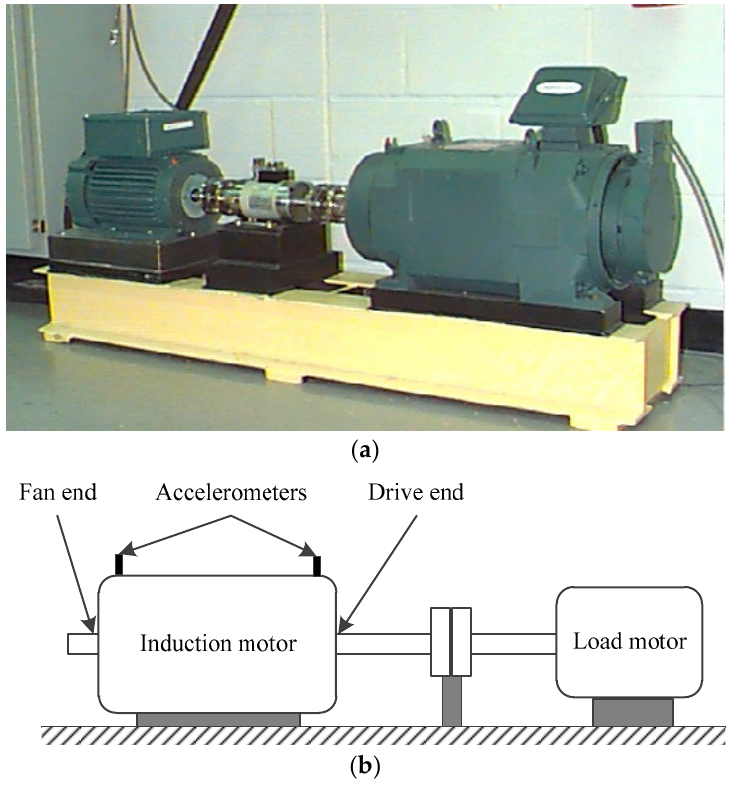
Figure 6. ( a ) Bearing test stand, and ( b ) its structural diagram.